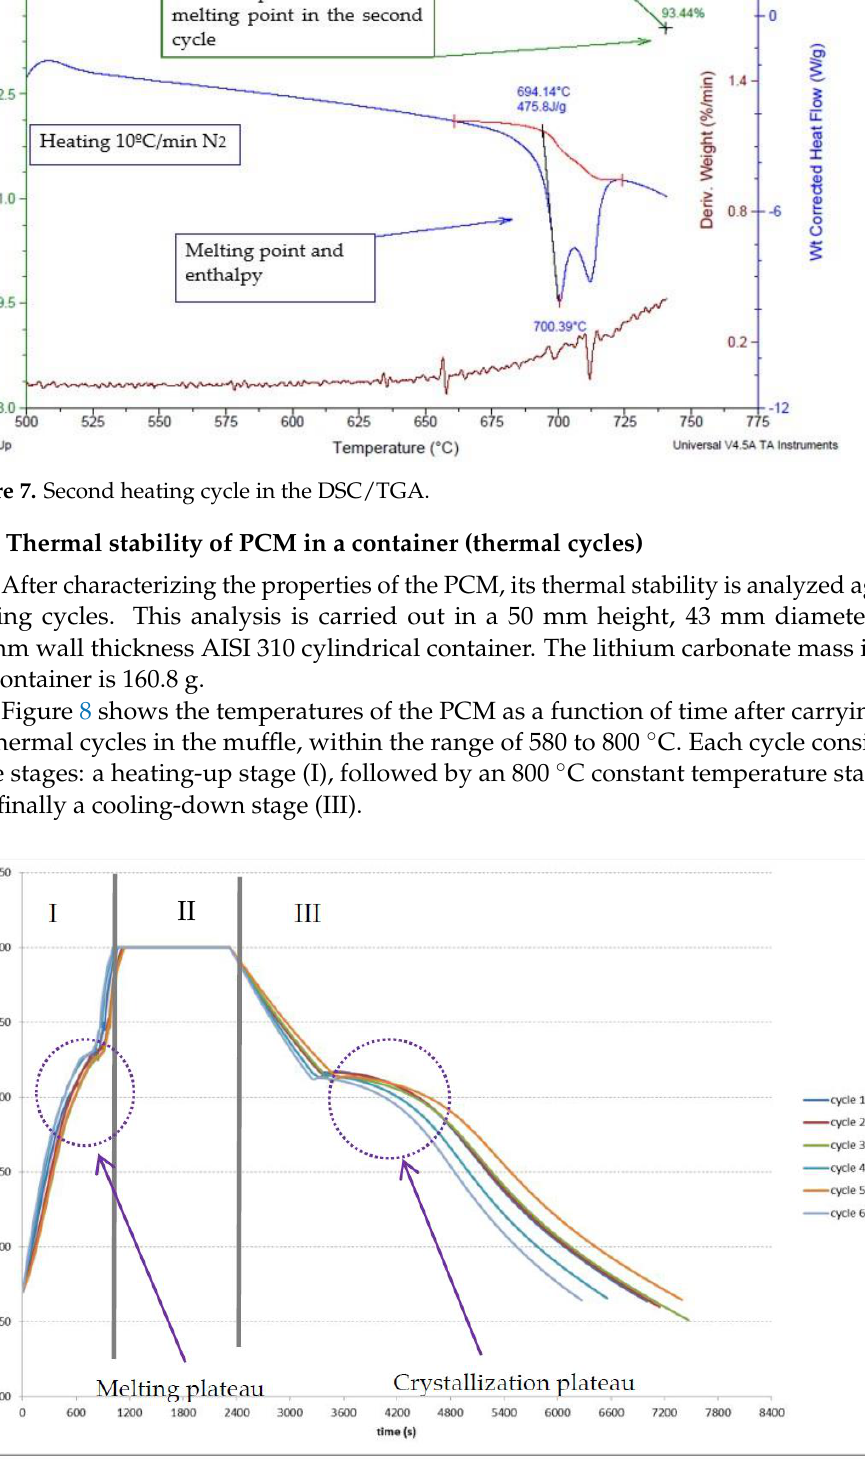
Figure 8. Thermal Figure 8. Thermal cycles. Figure 8. Thermal cycles.